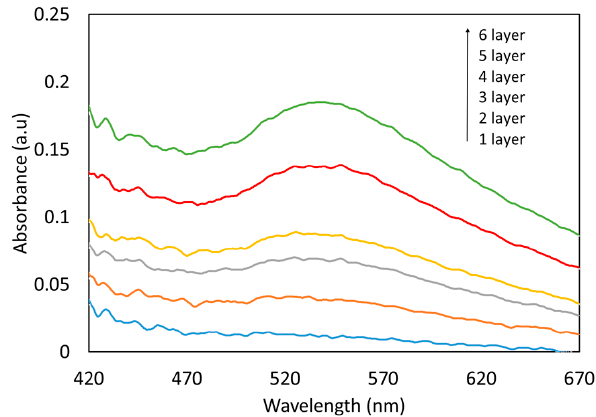
Figure 3. Absorption spectra of LSPR resonance wavelength for every layer of (PAH/PAA+AuNPs) deposited on 200 μ m-core optical fiber .